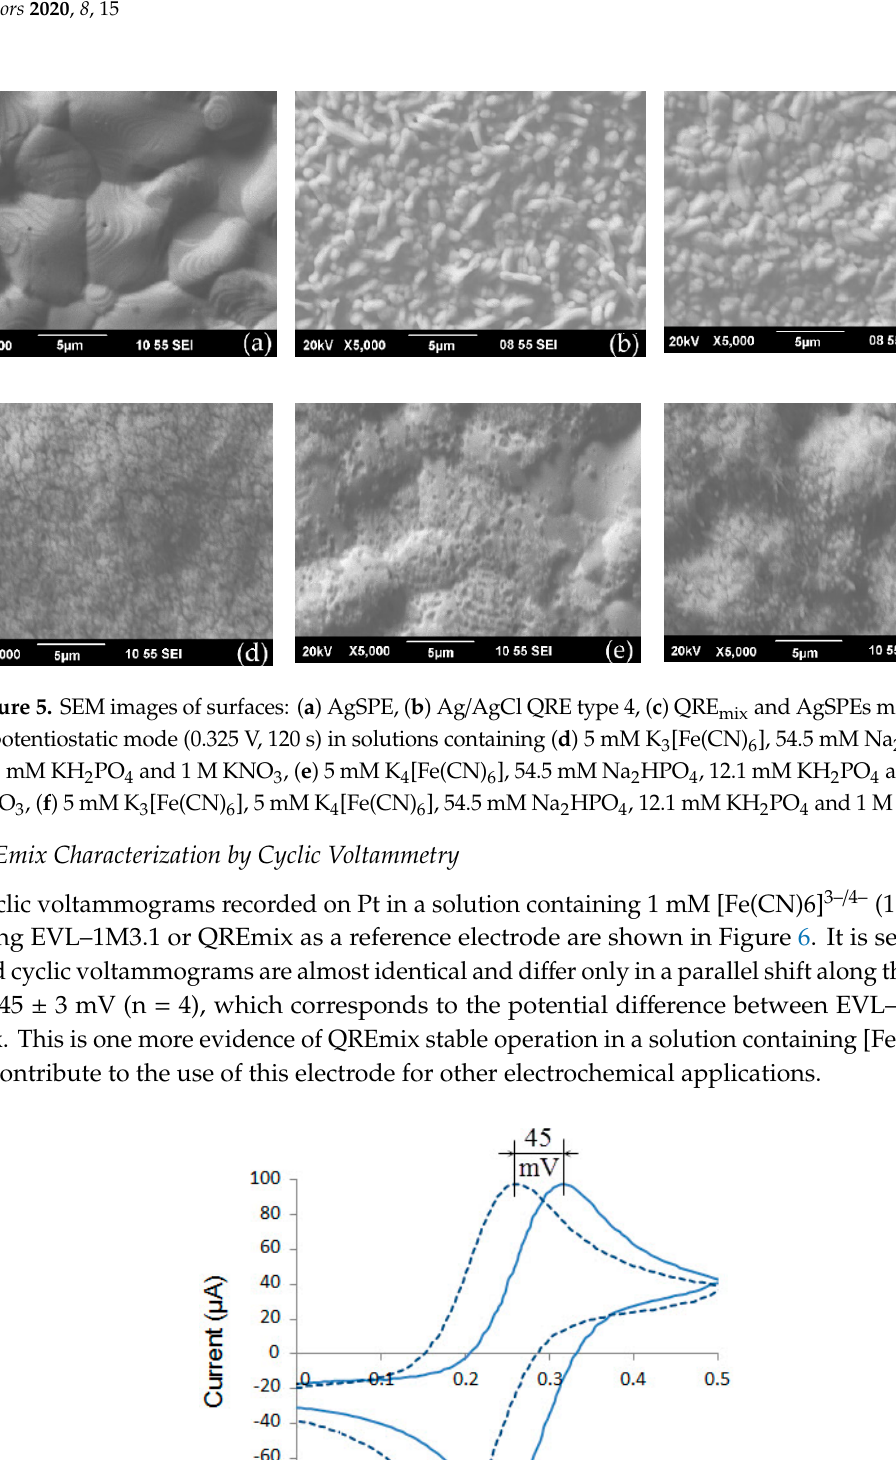
Figure 6. Cyclic voltammograms recorded on Pt in a solution containing 1 mM K 3 [Fe(CN) 6 ], 1 mM K 4 [Fe(CN) 6 ] and 1 M KCl, using EVL–1M3.1 (solid line) and QRE mix (dashed line) as a reference electrode.